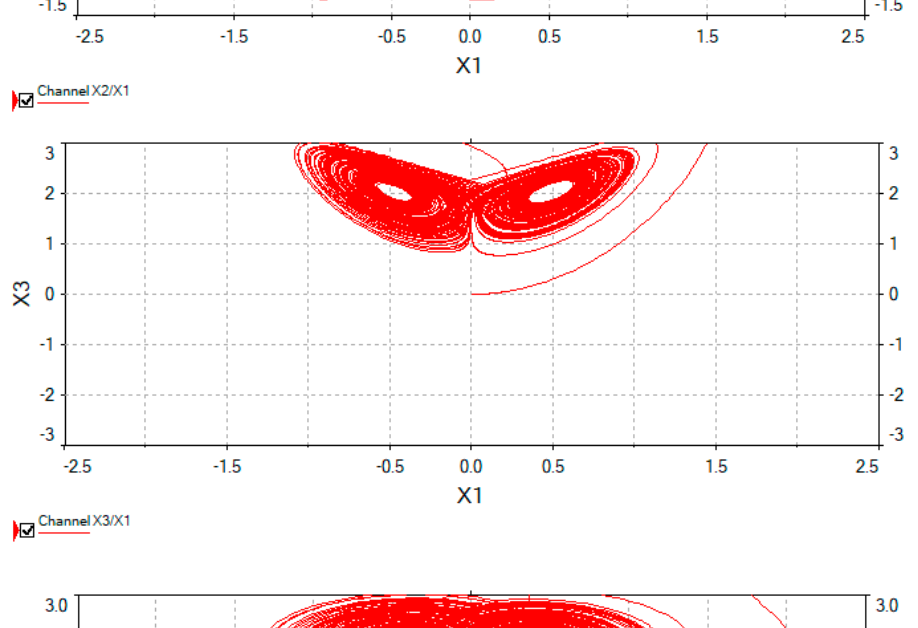
9 of 16 Figure 9. The schematic circuit of the fractional-order chain system. The circuit equation is as follows: 𝑑 (cid:3044) 𝑋1 𝑑𝑡 = 𝑅 (cid:2870) 𝑅 (cid:2869) 𝑅 (cid:2872) 𝑋2 − 𝑅 (cid:2870) 𝑅 (cid:2873) 𝑅 (cid:2869) 𝑅 (cid:2871) 𝑅 (cid:2874) 𝑋1 𝑑 (cid:3044) 𝑋2 𝑑𝑡 = 𝑅 (cid:2876) 𝑅 (cid:2875) 𝑅 (cid:2869)(cid:2868) 𝑋1 − 𝑅 (cid:2876) 𝑅 (cid:2869)(cid:2869) 𝑅 (cid:2875) 𝑅 (cid:2877) 𝑅 (cid:2869)(cid:2870) 𝑋2 − 𝑅 (cid:2876) 𝑅 (cid:2869)(cid:2869) 𝑅 (cid:2875) 𝑅 (cid:2877) 𝑅 (cid:2869)(cid:2871) 𝑋1𝑋3 𝑑 (cid:3044) 𝑋3 𝑑𝑡 = 𝑅 (cid:2869)(cid:2873) 𝑅 (cid:2869)(cid:2872) 𝑅 (cid:2869)(cid:2875) 𝑋1𝑋2 − 𝑅 (cid:2869)(cid:2873) 𝑅 (cid:2869)(cid:2876) 𝑅 (cid:2869)(cid:2872) 𝑅 (cid:2869)(cid:2874) 𝑅 (cid:2869)(cid:2877) 𝑋3